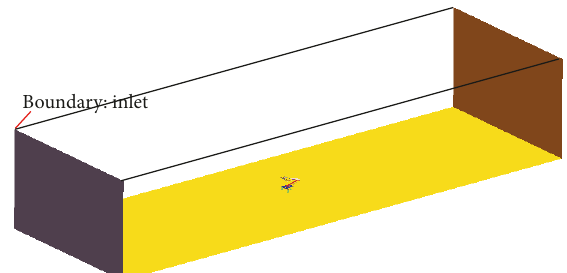
Figure 2: The computational domain of pantographs in high-speed trains.